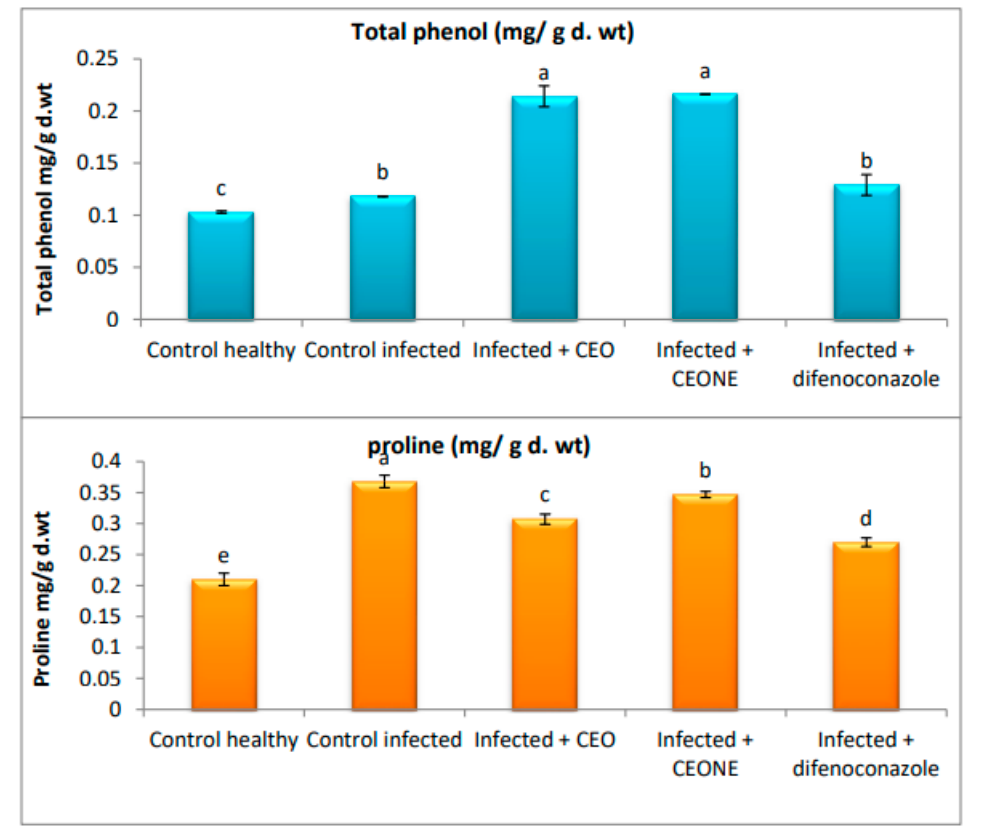
Figure 7. Effect of CEO and CEONE on proline and phenol content of C. carvi . Letters a,b,c,d,e mean Figure 7. E ff ect of CEO and CEONE on proline and phenol content of C. carvi . Le tt ers a,b,c,d,e mean power of signi fi cance. power of